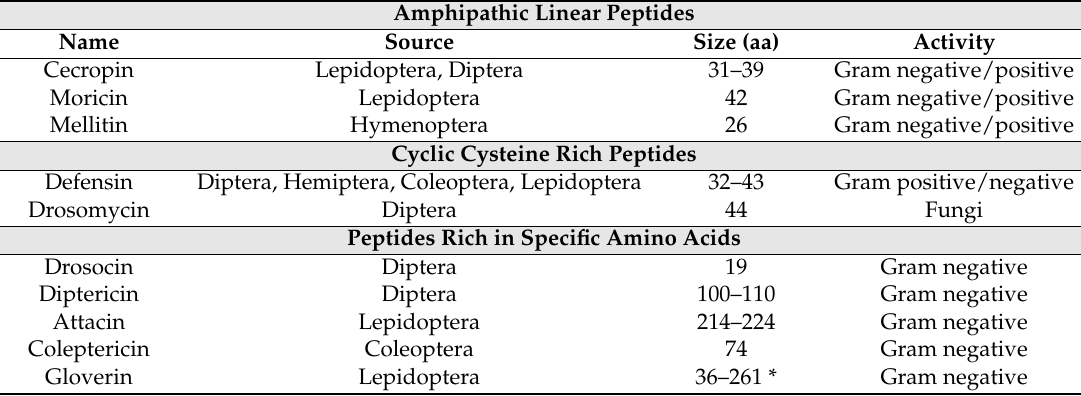
Table 1. Example of some insects’ antimicrobial peptides (AMPs).